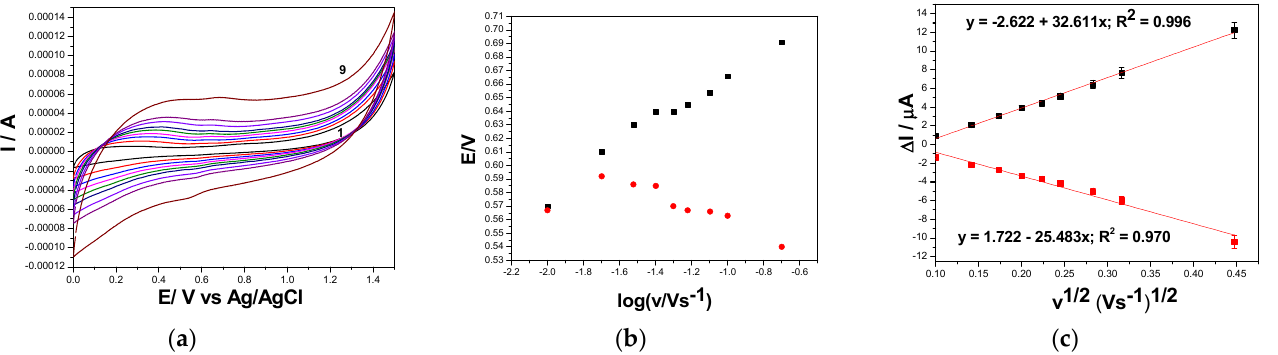
Figure 7. ( a ) Cyclic voltammograms recorded in 5 mg · L − 1 DOX and 0.1 M Na 2 SO 4 supporting electrolyte with the GRQD/CNT paste electrode at various scan rates: (curve 1) 10, (curve 2) 20, (curve 3) 30, (curve 4) 40, (curve 5) 50, (curve 6) 60, (curve 7) 80, (curve 8) 100, and (curve 9) 200 mV · s − 1 . ( b ) Dependence of peak potential vs. logarithm of the scan rate. ( c ) Dependence of anodic peak current vs. square root of the scan rate.